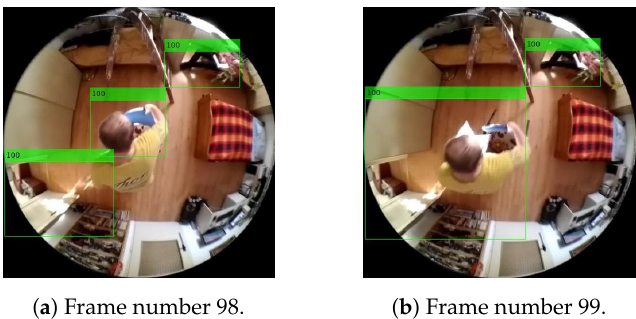
Figure 25. Example of merging person findings. The illustration shows the real results of Method 1.1, with a lifespan of 1s, i.e., 4 frames at a frame rate of 4fps. Table 1. Table of currently detected findings in the scene of frame 43.